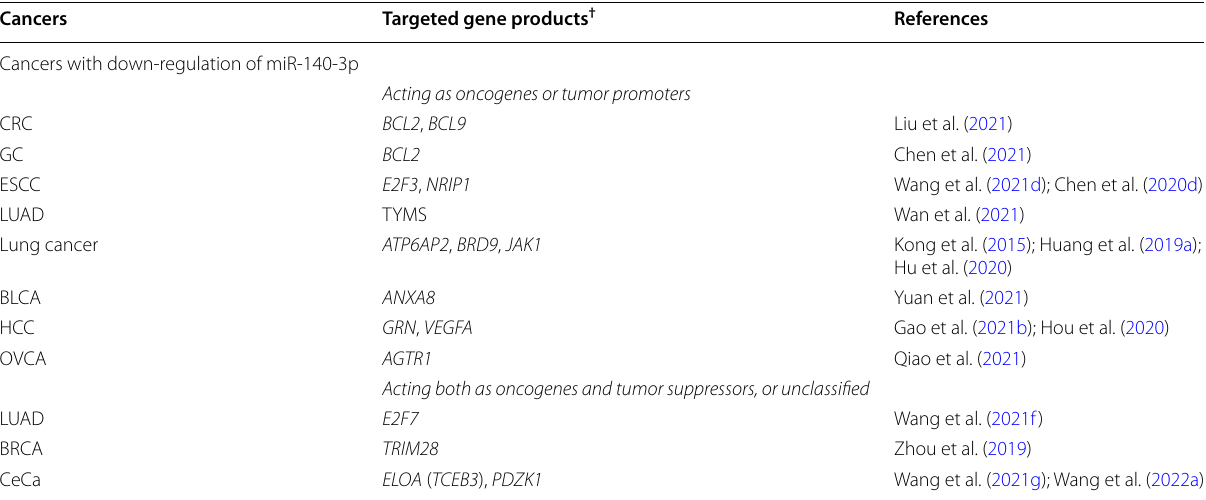
Table 5 Major genes targeted by miR-140-3p in various types of